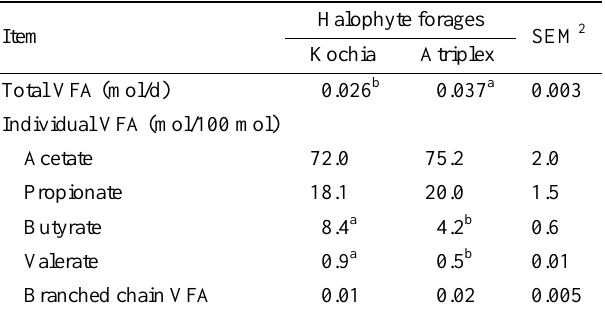
Table 3. Volatile fatty acid concentration and molar proportions of individual volatile fatty acids of Kochia scoparia and Atriplex dimorphostegia in continuous culture fermenters 1